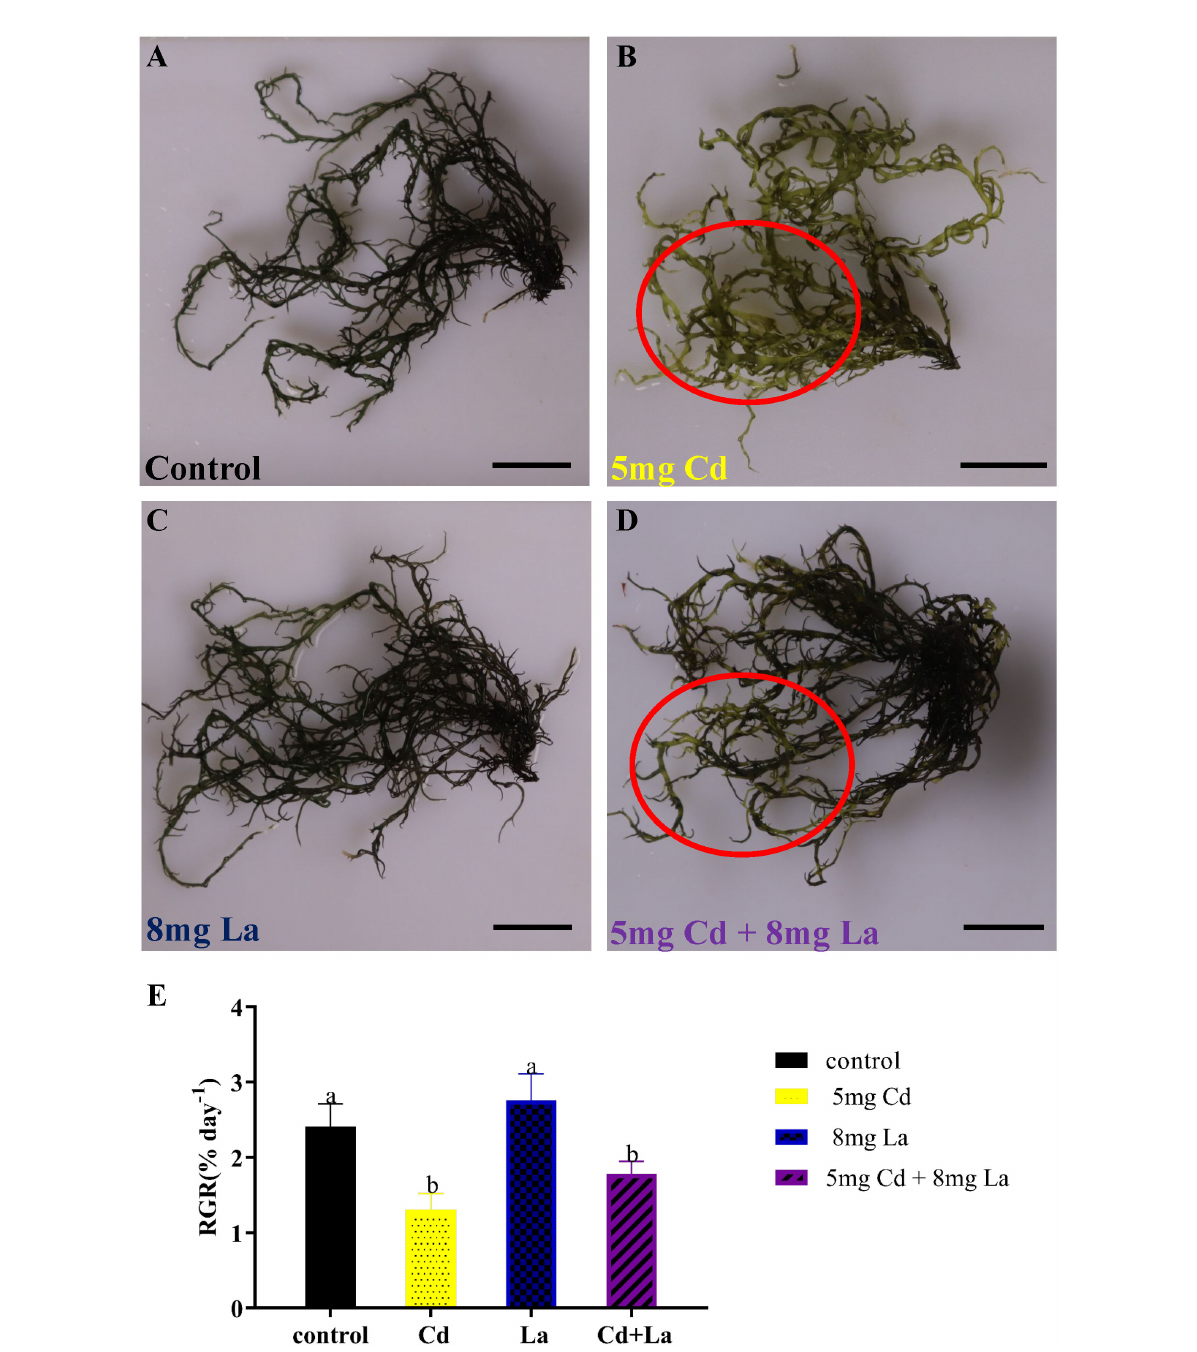
FIGURE 1 Impact of Cd, La, and their combination on G. bailiniae : (A – D) morphological changes, and (E) relative growth rate (RGR). Units: mg L − 1 . Red circles denote the discoloration of G. bailiniae . The scale bar represents 2 cm. The RGR data are presented as the mean ± standard deviation (n = 3). The lowercase letters indicate signi fi cant differences (ANOVA/Duncan ANOVA, P<